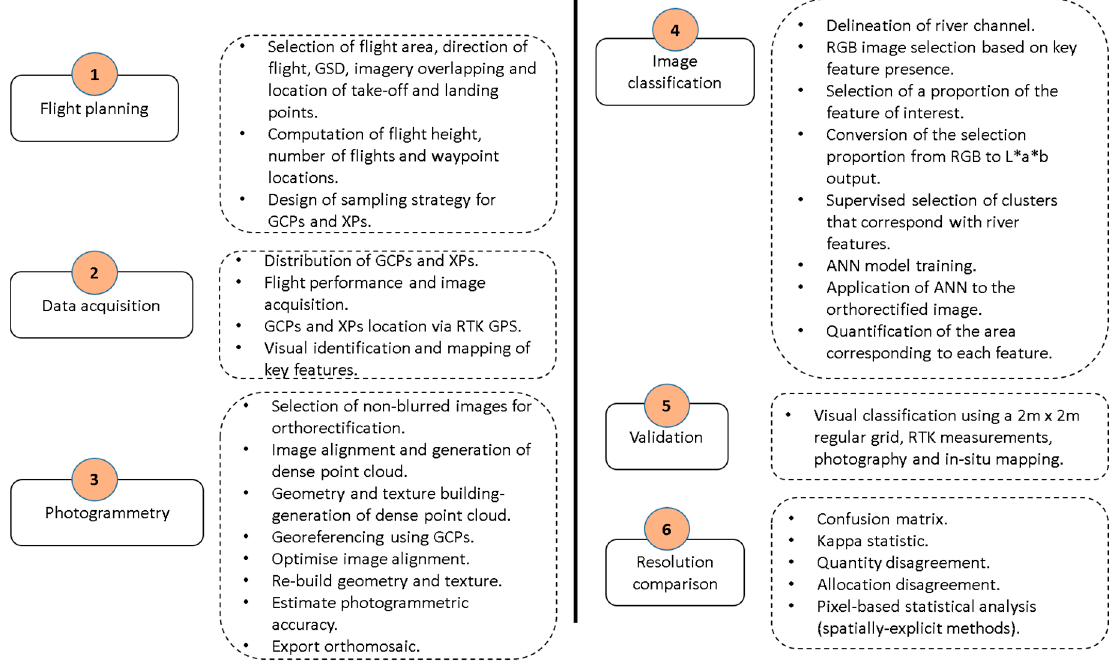
Figure 3. Workflow followed in this paper from flight planning to data interpretation. GSD, GCP, XP, RTK and ANN stand for Ground Sample Distance, Ground Control Point, Check Point, Real Time Kinematic and Artificial Neural Network, respectively.